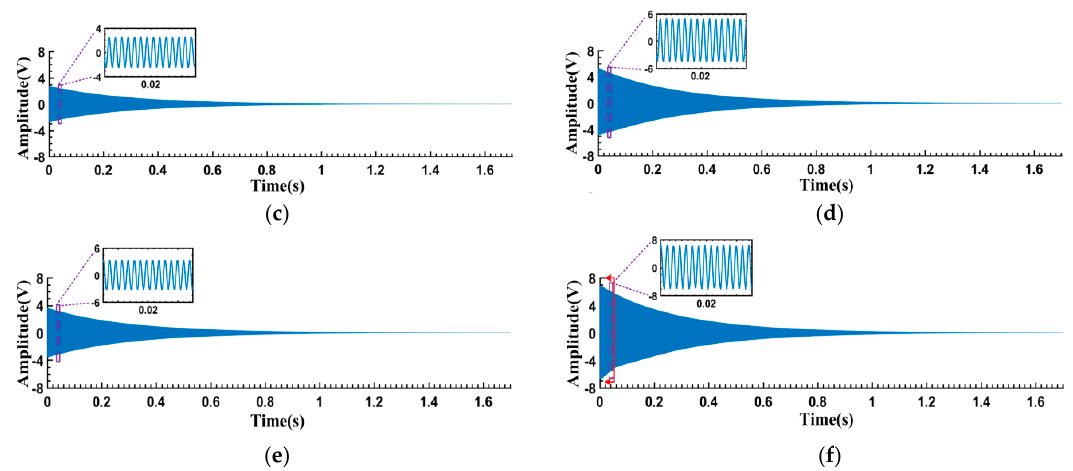
Figure 10 . Free vibration signals of the largest response segments in Figure 9: ( a ) 50 mV; ( b ) 75 mV;